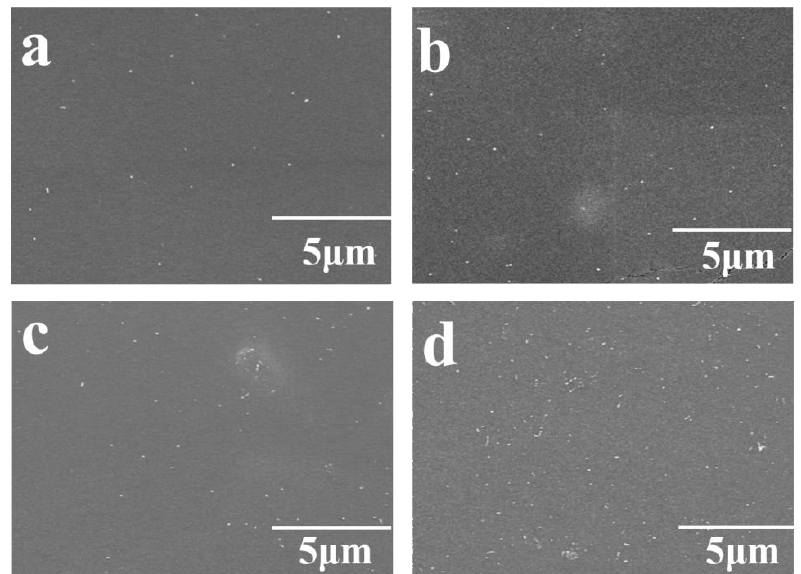
Figure 4. The cross-sectional views of CNTs/PDMS composite films based on different mass fraction of CNTs with the aspect ratios of 1250–3750, (a) 1 wt.%, (b) 2 wt.%, (c) 3 wt.%, (d) 3.75